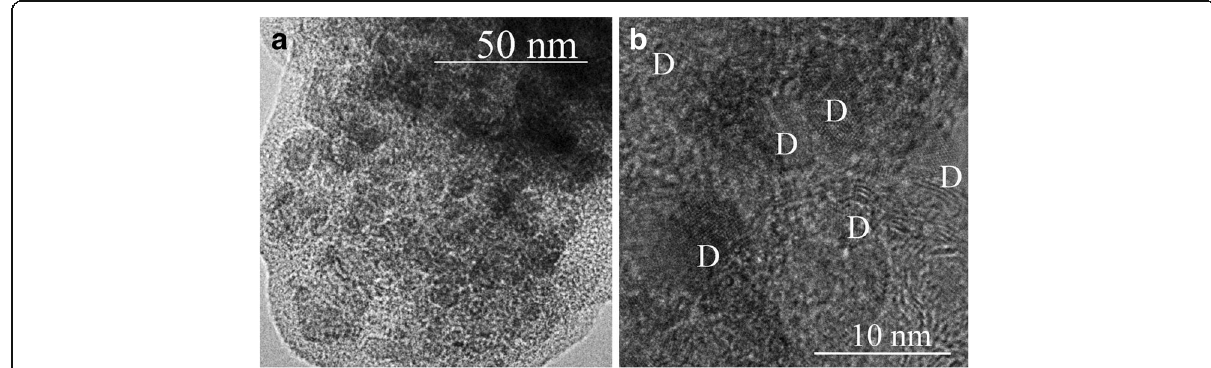
Fig. 2 TEM images of nanodiamond mixed with Si after the planetary mill treatment. The nanodiamond grains are separated by disordered Si. The grain size lies in the range of 2 – 5 nm. a General view. ( b ) High-resolution image. Nanodiamond grains are market by D in b